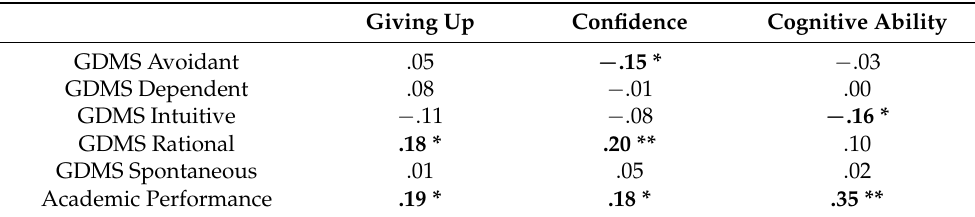
Table 4. Correlations between the giving up, confidence, and cognitive ability factors with decision- making styles and academic performance. Giving Up Confidence Cognitive Ability GDMS Avoidant .05 − .15 * − .03 GDMS Dependent